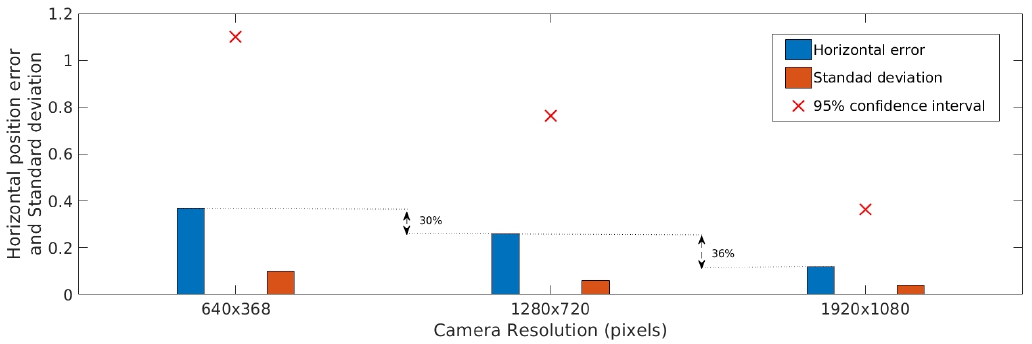
Figure 5. Absolute horizontal accuracy estimation for different camera resolution. Table 3. Means and standard deviations for absolute horizontal error, height error, and orientation error read in the static